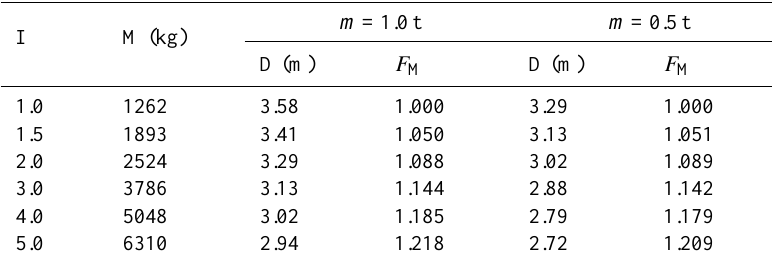
Table 1. Analytical computation of the Displacement controlling mass factors for the R-LPR structure at two different impact scenarios each resulting in the same specified impact energy of 150kJ. I=Mass increment factor; D=displacement response; M=structural mass; F M =Displacement controlling mass factor.